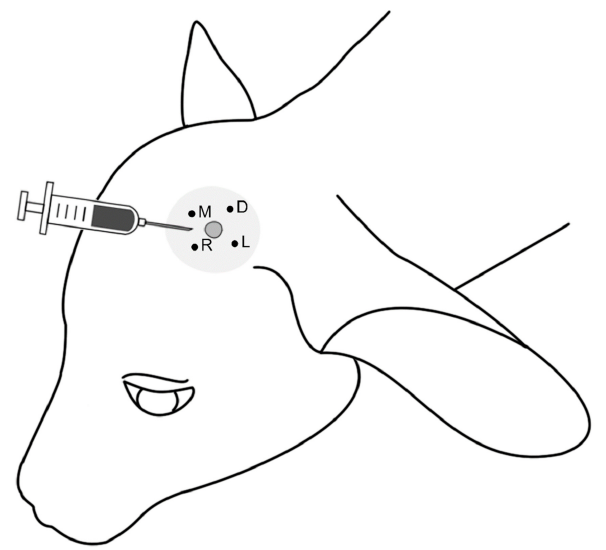
Figure 1. Locations used for the assessment of the mechanical nociceptive threshold (R: rostral, M: medial, L: lateral, D: dorsal). All four locations were used with the pressure algometer, only the lateral one with the von Frey filaments. The syringe indicates the direction of the saline, clove oil or isoeugenol